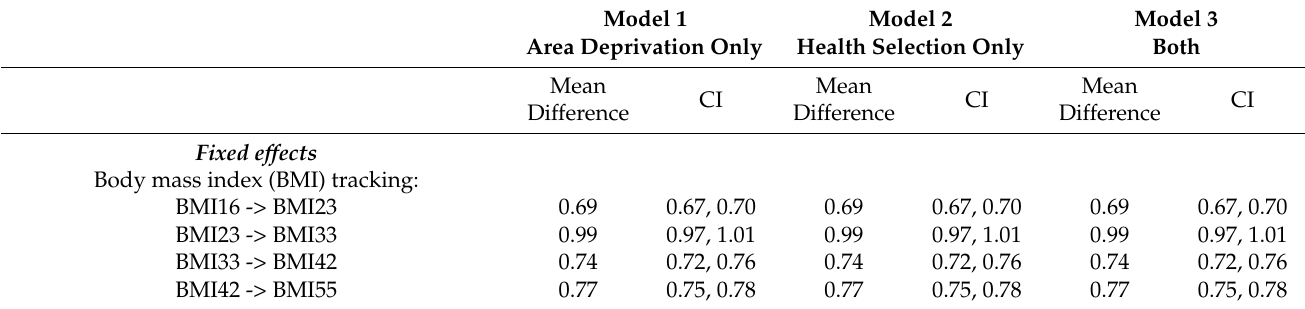
Table 3. Direct effects modelled using structural equation modelling and multiple imputation (1958 cohort, n =